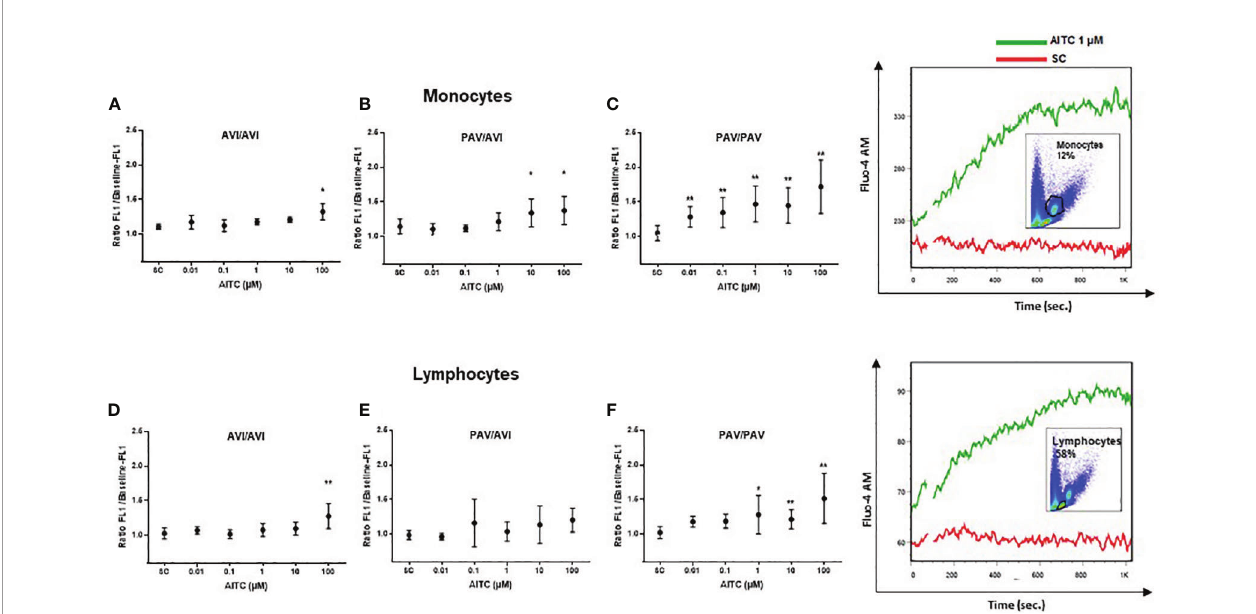
FIGURE 1 | Mobilization of calcium in human PBMC with different TAS2R38 haplotypes after stimulation with AITC. PBMC were isolated and exposed to AITC or solvent control (SC, 0.1% DMSO). Flow cytometry based measurement of calcium fl ux was detected in monocytes (A – C) and lymphocytes (D – E) probed with Fluor- 4 AM (F EM:516 nm ) after treatment with compounds. Baseline fl uorescence was recorded for 60 sec before exposure. After exposure, fl uorescence was measured for another 740 sec. Calcium response was calculated as the ratio of the maximum peak post stimulation to basal level using FlowJo software. Dots represent mean values ± SD, n ≥ 4 of cells from AVI/AVI (A , D), PAV/AVI (B , E) and PAV/PAV (C , F) subjects. Representative pictures of the gating strategy for monocytes or lymphocytes, and calcium fl ux response to AITC or SC from one subject are given on the right. Signi fi cance of difference was determined using paired t-test compared to the respective SC, *p<0.05,